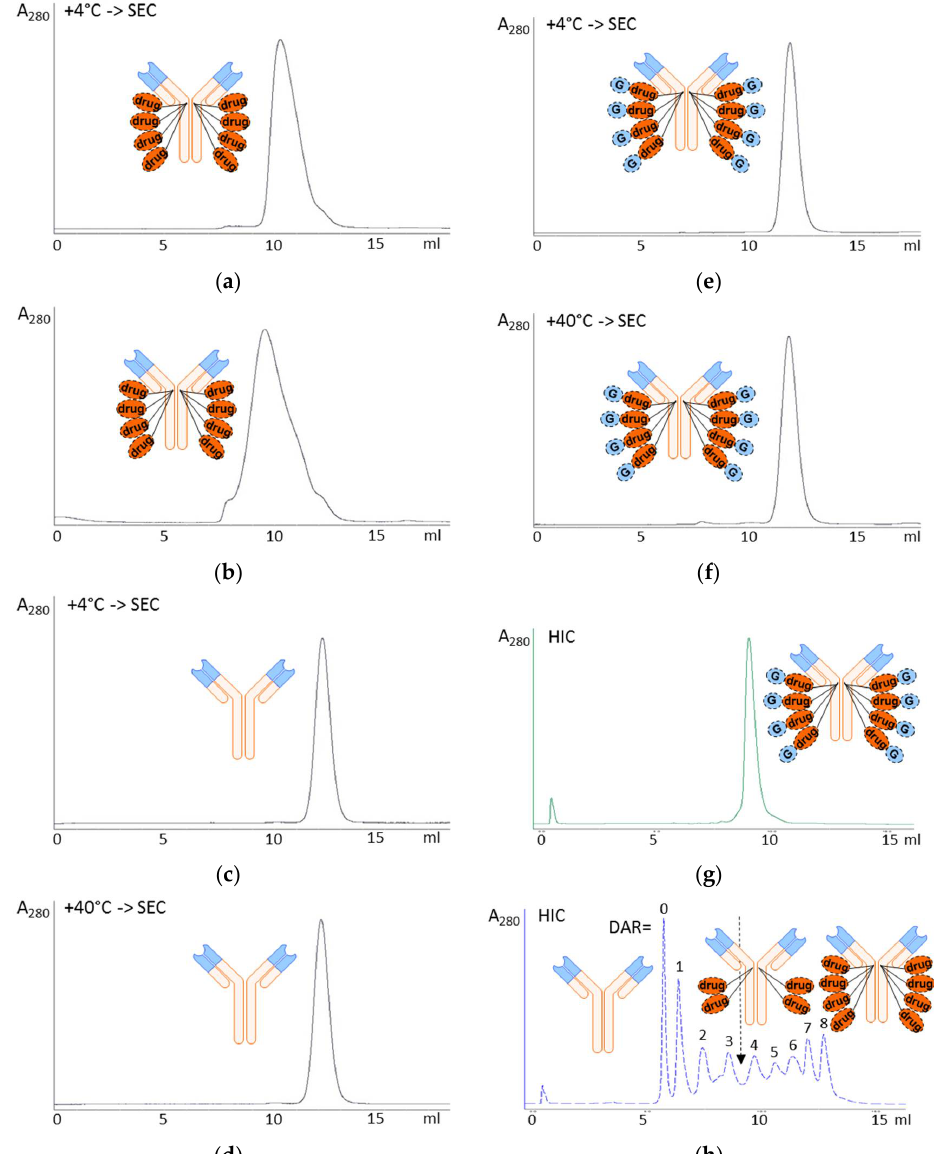
Figure 2. Chromatographic evaluation of ADC aggregation and hydrophilicity. ( a – f ) Aggregation was analyzed by size-exclusion chromatography (SEC) after two days’ storage at +4 °C (normal storage temperature) or +40 °C (temperature stress) in formulation buffer. ( a , b ) DAR = 8 trastuzumab MMAE ADC was moderately aggregated into HMWCs already at +4 °C in two days ( a ) and mostly (>95%) aggregated at +40 °C eluting as a broad peak between 7–12 mL ( b ). ( c , d ) Trastuzumab, the naked antibody control, was not aggregated at either +4 °C ( c ) or +40 °C ( d ) during storage and eluted at 12.1 mL. ( e , f ) DAR = 8 MMAU ADC was not aggregated at +4 °C eluting at 11.9 mL ( e ) and only 2% aggregated into high-molecular weight components (HMWCs) eluting at 7–8 mL at +40 °C ( f ). ( g , h ) Hydrophobic interaction chromatography (HIC) was performed for evaluating the relative hydrophilicity of DAR = 8 trastuzumab-MMAU ADC ( g ); and a standard mixture of the naked antibody trastuzumab as well as trastuzumab-MMAE ADCs with DAR = 1–8 constructed from reduced trastuzumab using standard MC-Val-Cit-PABC linker ( h ). The method separated the molecules in the order of relative hydrophobicity, with the most hydrophilic component (naked antibody) eluting first and the most hydrophobic component (DAR = 8 ADC) eluting last. DAR = 8 MMAU ADC eluted at position corresponding to DAR = 3–4 MMAE ADC. Detection was by absorbance at 280 nm. drug, MMAE; G, β - D -glucuronic acid